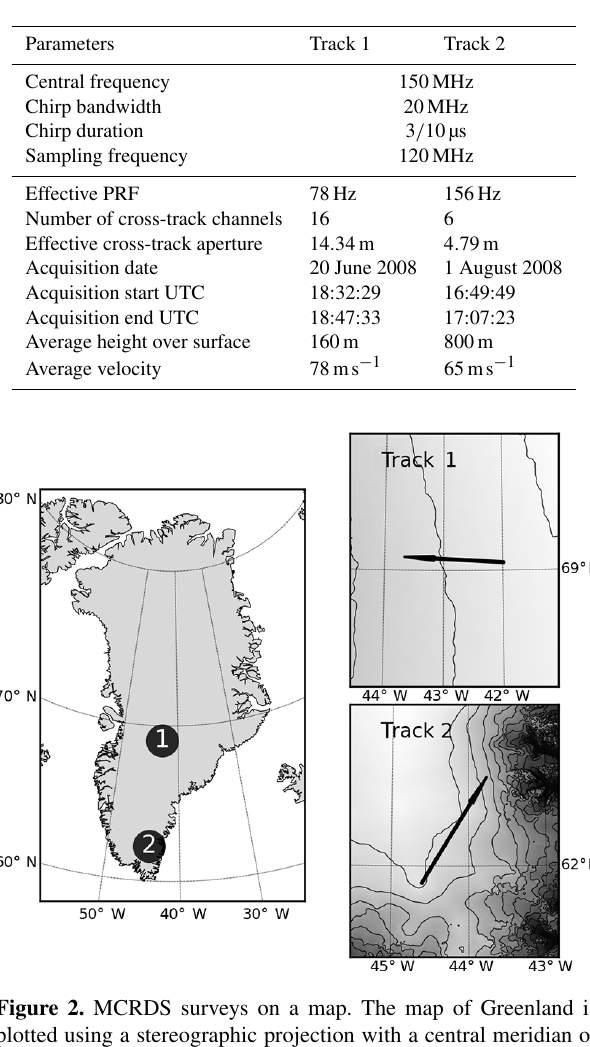
Table 1. Parameters of MCRDS acquisitions.